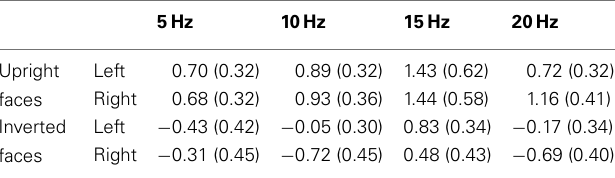
Table 2 | Mean N170 amplitudes ( µ V) across participants with SEM, averaged across a left (11 sensors including PO7 and P9) and a right (10 sensors including PO8 and P10) sensor grouping, for both upright and inverted faces for all frequency